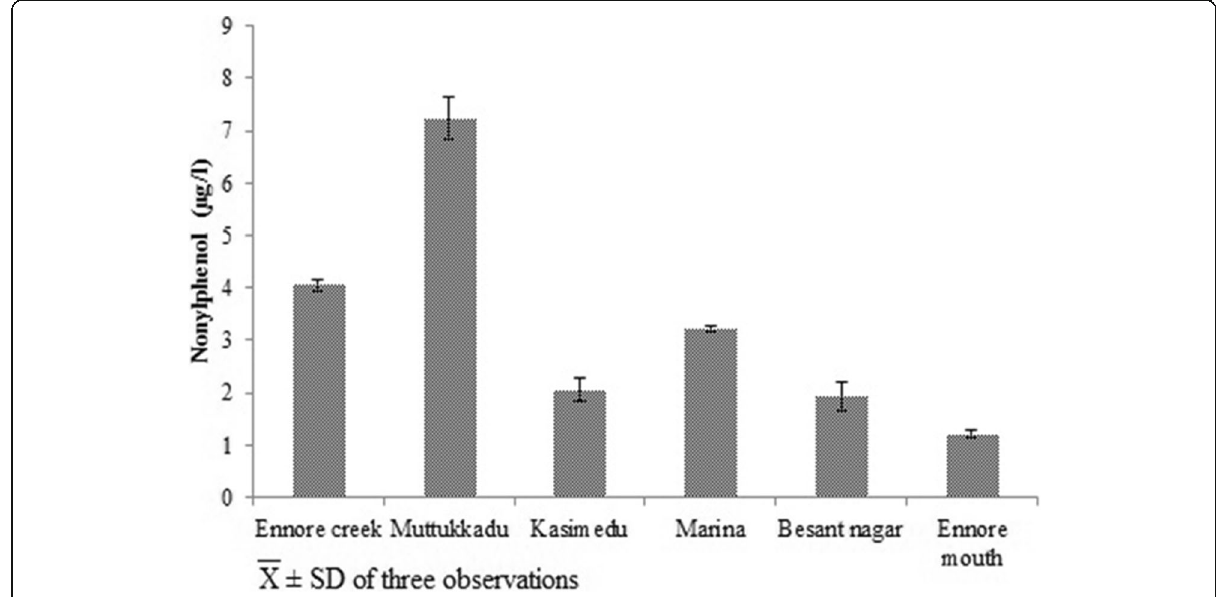
Fig. 2 Concentration of nonylphenol in water samples collected from six